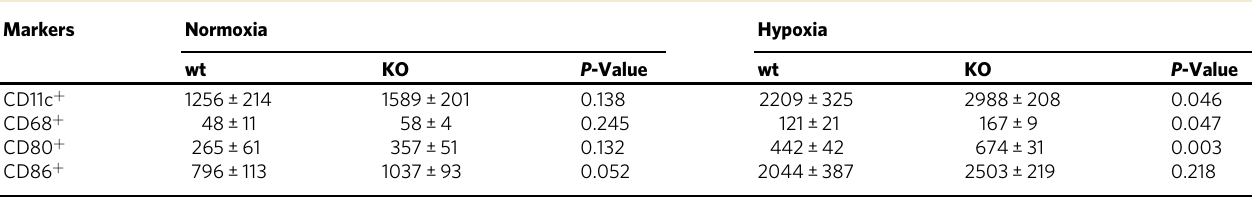
Table 1 Number of macrophages expressing markers of M1 polarization per 500,000